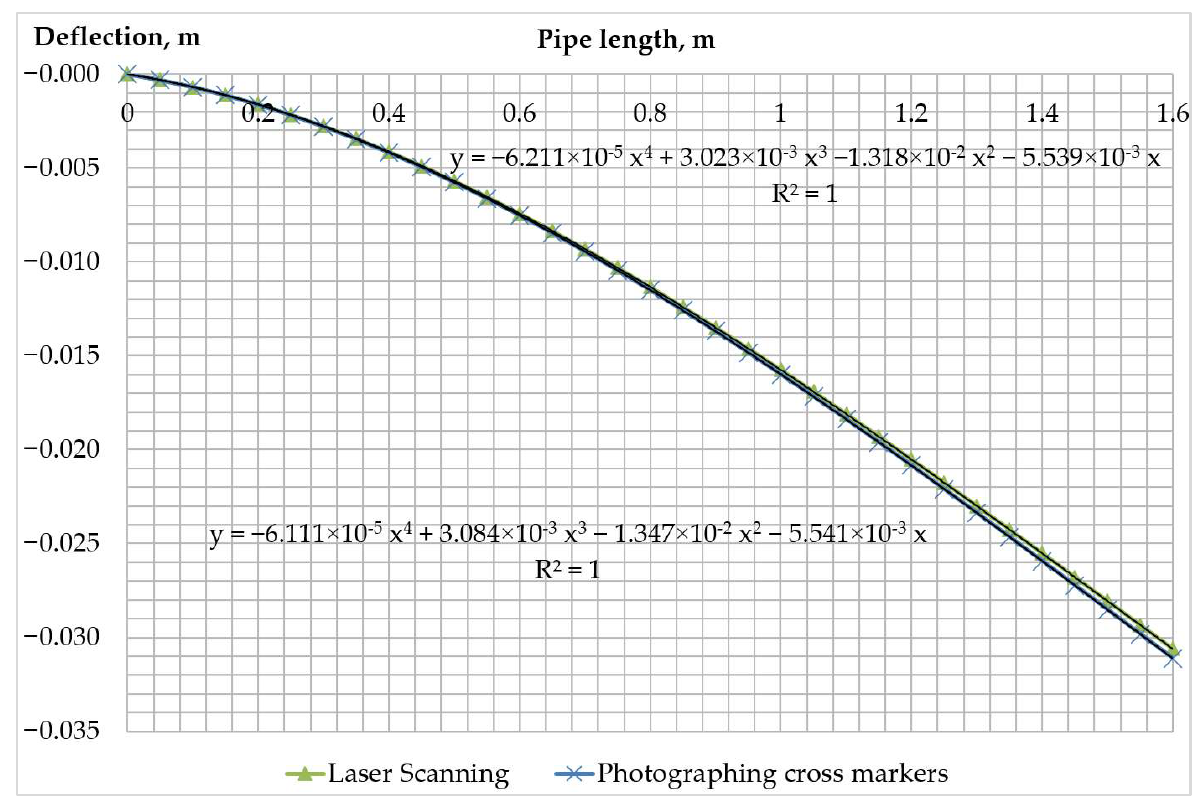
Figure 18. The curve of the deflection of the pipeline obtained by the method of laser scanning and photographing cross markers.